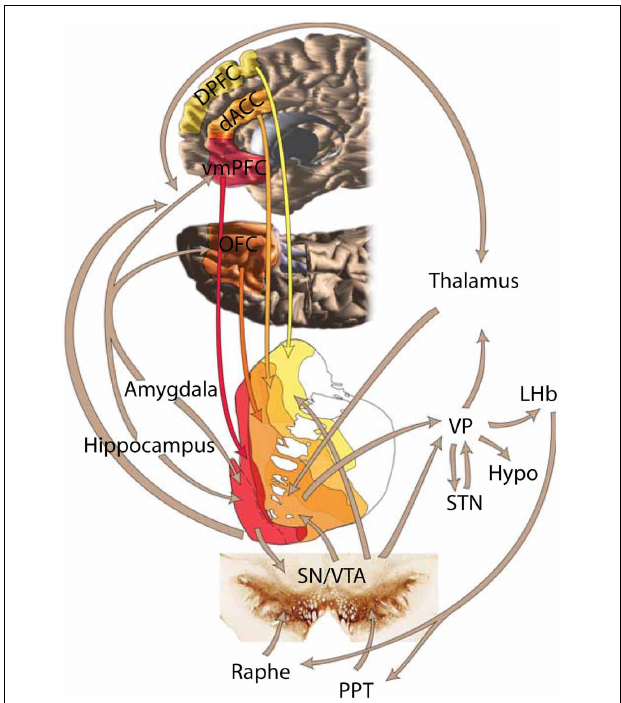
FIGURE 1 | Depiction of the brain’s reward circuit highlighting the role of the striatum and its anatomical connections. Abbreviations: dACC, dorsal anterior cingulate cortex; DPFC, dorsal prefrontal cortex; vmPFC, ventromedial prefrontal cortex; VP, ventral pallidum; LHb, lateral habenula; Hypo, hypothalamus; STN, subthalamic nucleus; SN, substantia nigra; VTA, ventral tegmental area; PPT, pedunculopontine tegmentum. Based on Haber and Knutson (2010), reproduced with